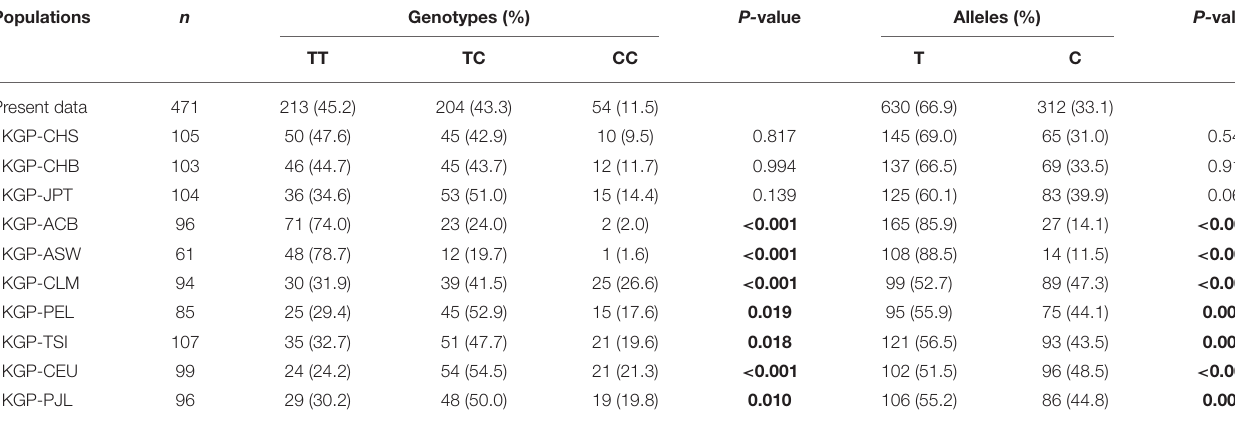
TABLE 5 | Genotypic and allelic distributions of rs11730582 among different populations.